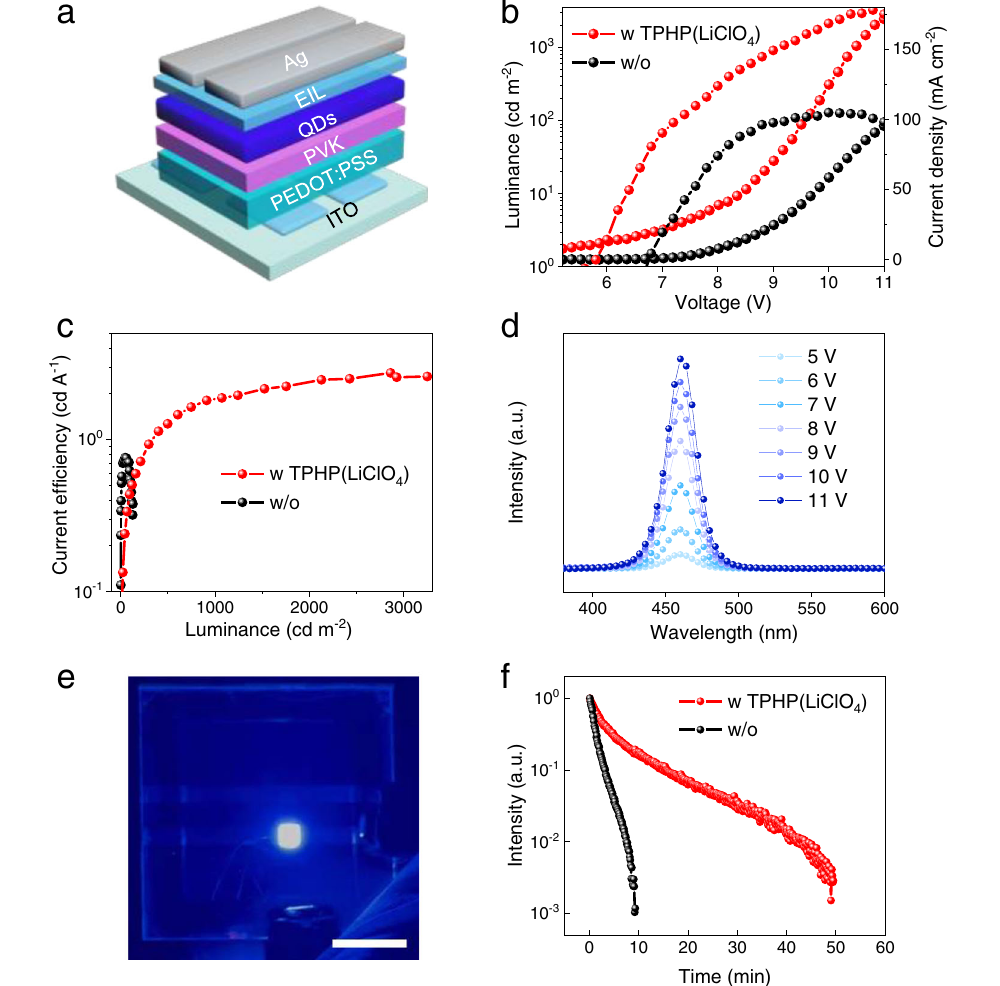
Fig. 4 | High-performance blue QD-LEDsenabled by TPHP(LiClO 4 ) EIL.a Device structure. b , c J-V - L ( b )and CE - L ( c )characteristicsforthe deviceswithandwithout 20-nm-thick2.2eVTPHP(LiClO 4 )EIL. d ELspectraofblueQD-LEDwith20-nm-thick 2.2eVTPHP(LiClO 4 )EIL. e AphotographofalightedblueQD-LED.Scalebaris1cm.